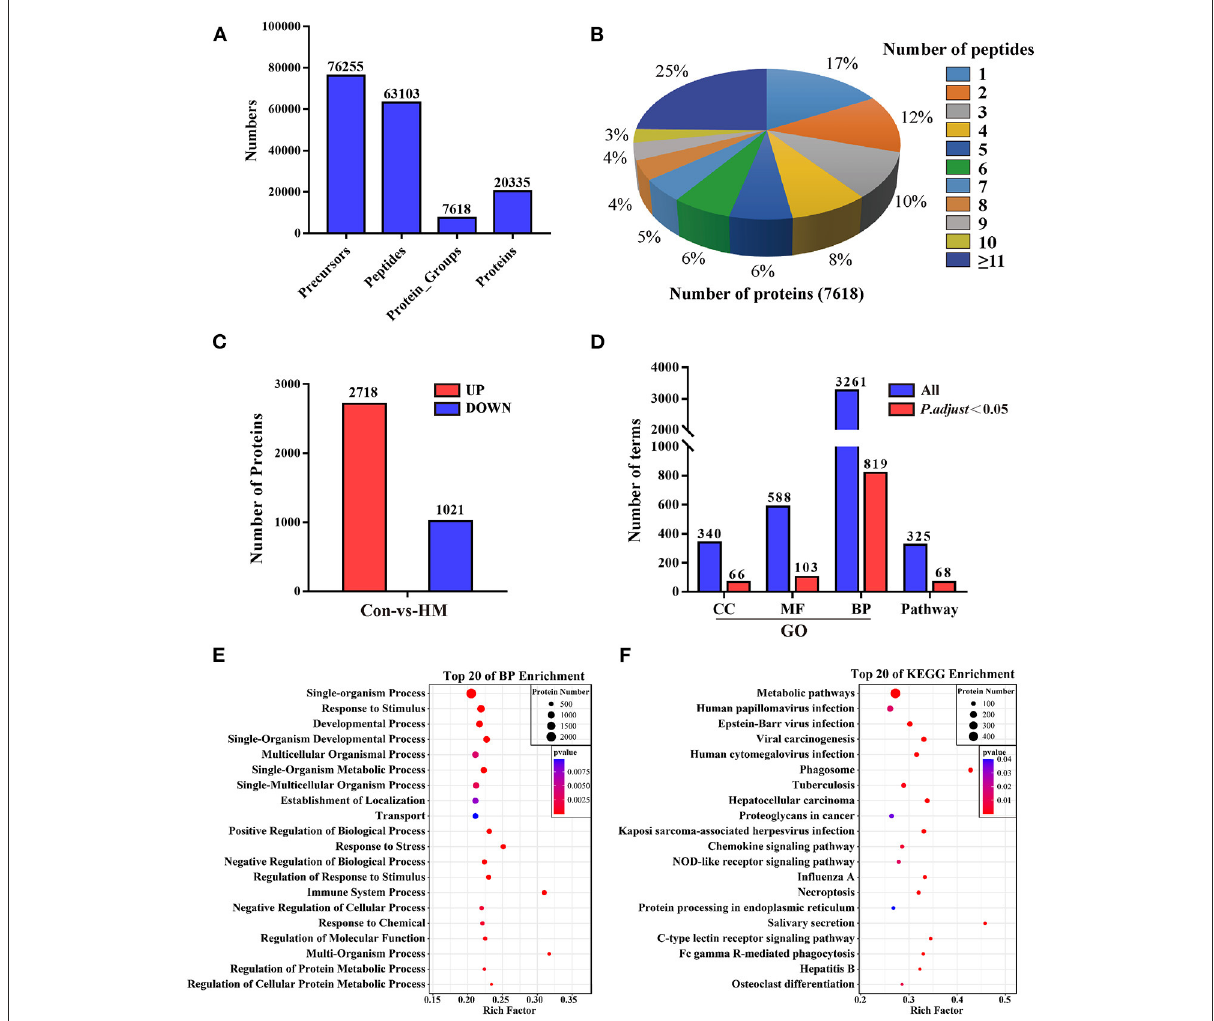
FIGURE2 Summary of the proteome analysis, protein identification and annotation in DIA data. (A) statistics for the peptides and proteins identification. (B) peptides number distribution analysis. The percentage represents the proportion of the number of peptides constituting the proteins. (C) statistics for the DEPs compared to the C group. (D) statistics for the GO terms including BP, MF, and CC, and pathway annotation. BP, biological process; MF, molecular function; CC, cellular component. (E,F) The top 20 biological process in GO annotation and the top 20 pathways in pathway annotation, respectively. Con, control group; HM, hemorrhagic mastitis group; GO, gene Ontology